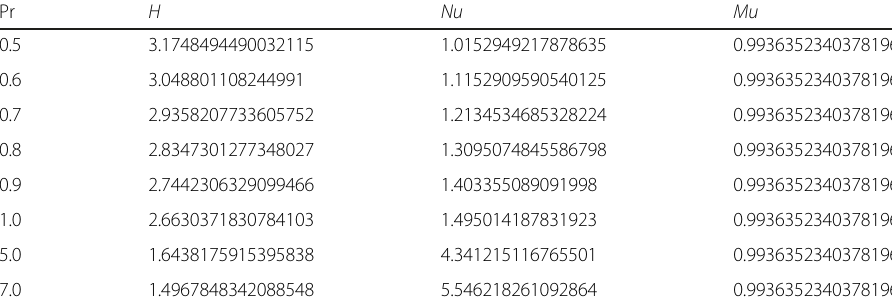
Table 4 Values of skin friction (H), Nusselt number ( Nu ), and Sherwood number ( Mu ) for different values of Pr Pr H Nu Mu 0.5